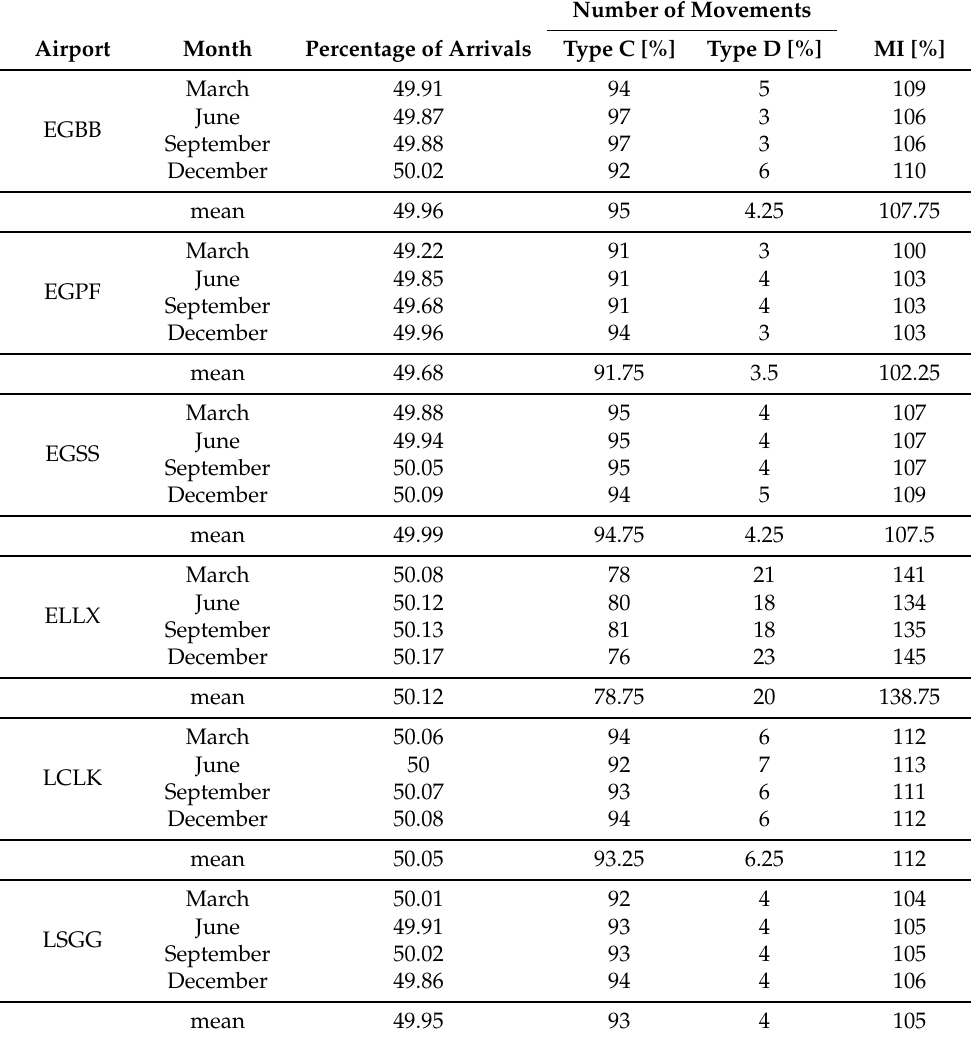
Table 4. Summary of indicators from the statistical analysis conducted in six selected airports concerning the aircraft fleet mix: monthly averaged values based on the total number of flight movements per day in the year of